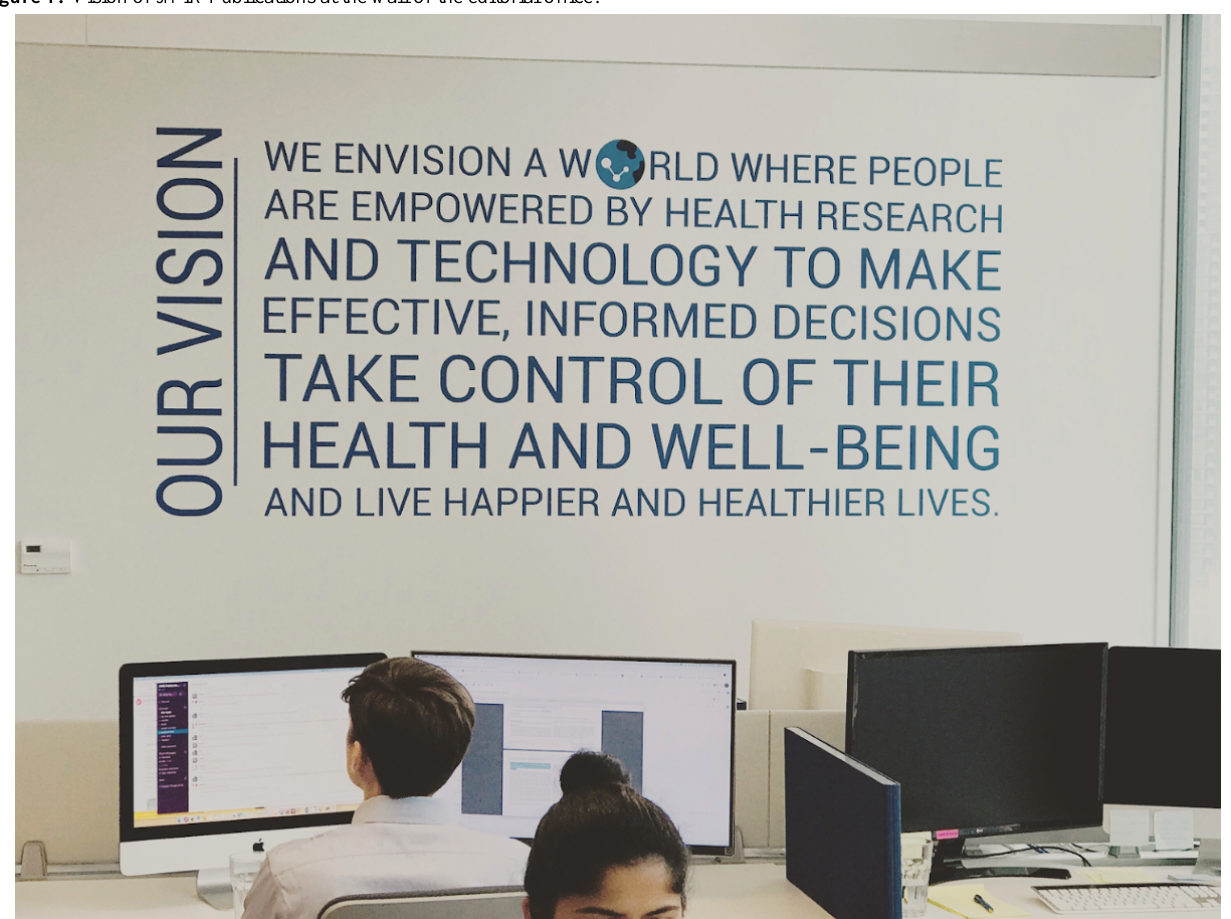
Figure 1. Vision of JMIR Publications at the wall of the editorial